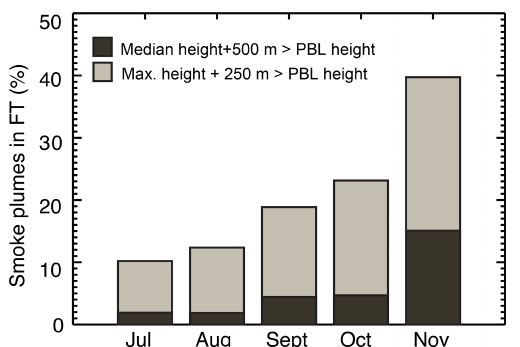
Figure 6. Seasonal variation of Amazon plume injection above the PBL (percent). Bar plots indicate the average of (median plume − PBL height) > 0.5km (dark grey) and (maximum plume − PBL height) > 0.25km (light grey) (see text for explanation).